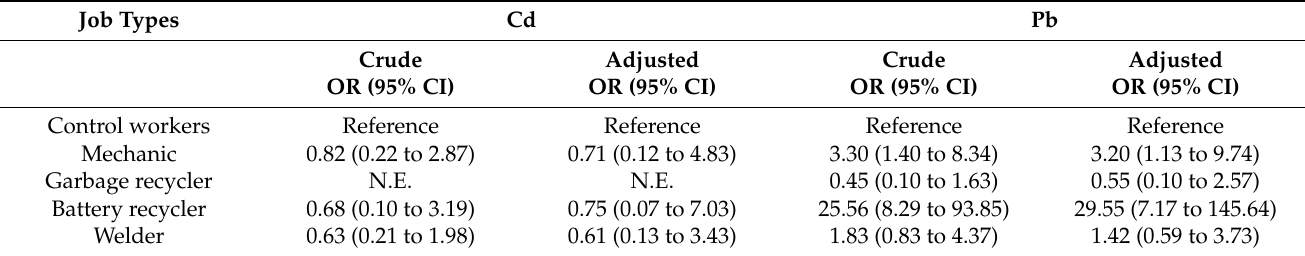
Table 4. Adjusted association between job type and high BCL and BLL, using logistic